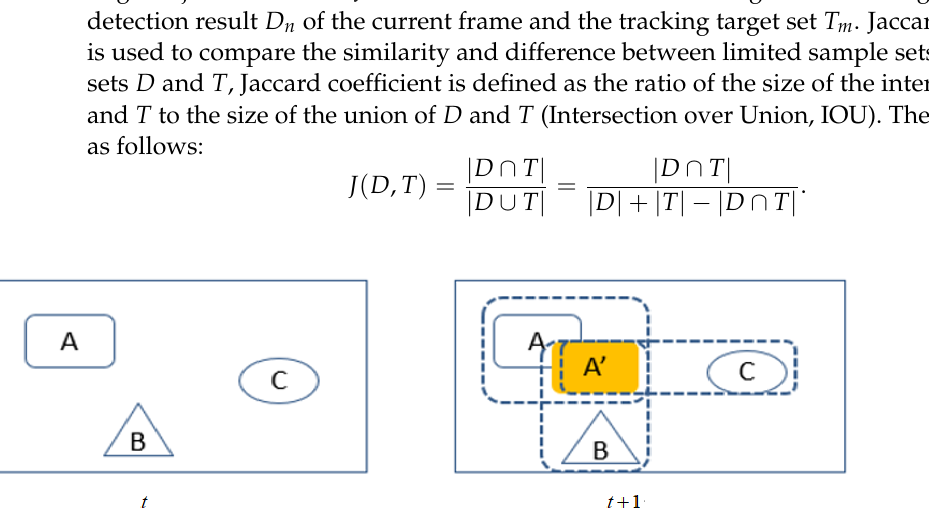
Figure 3. Target matching.